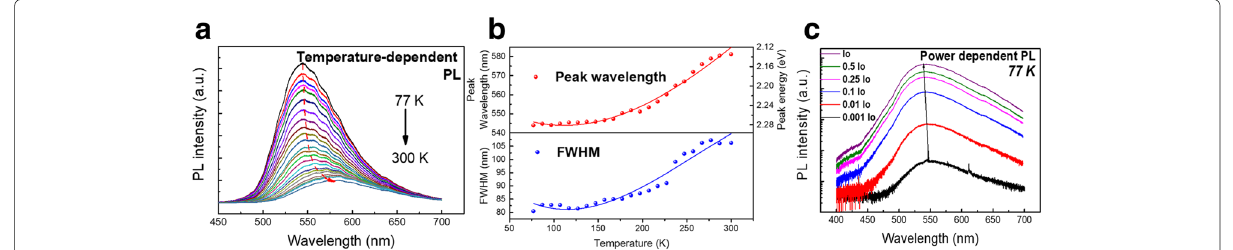
Fig. 2 a Temperature dependent PL measurement result from 77 to 300 K. b Change of peak wavelength and FWHM for temperature-dependent PL measurement. c Power-dependent μ -PL measurement performed at 77 K, indicating reduced quantum-confined Stark